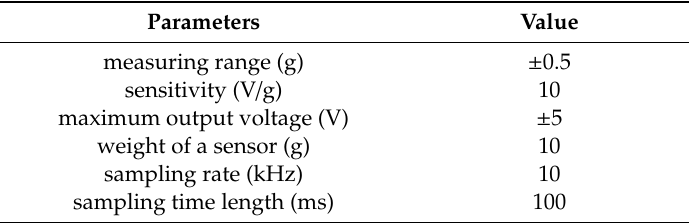
Table 1. Parameters of the acquisition system.